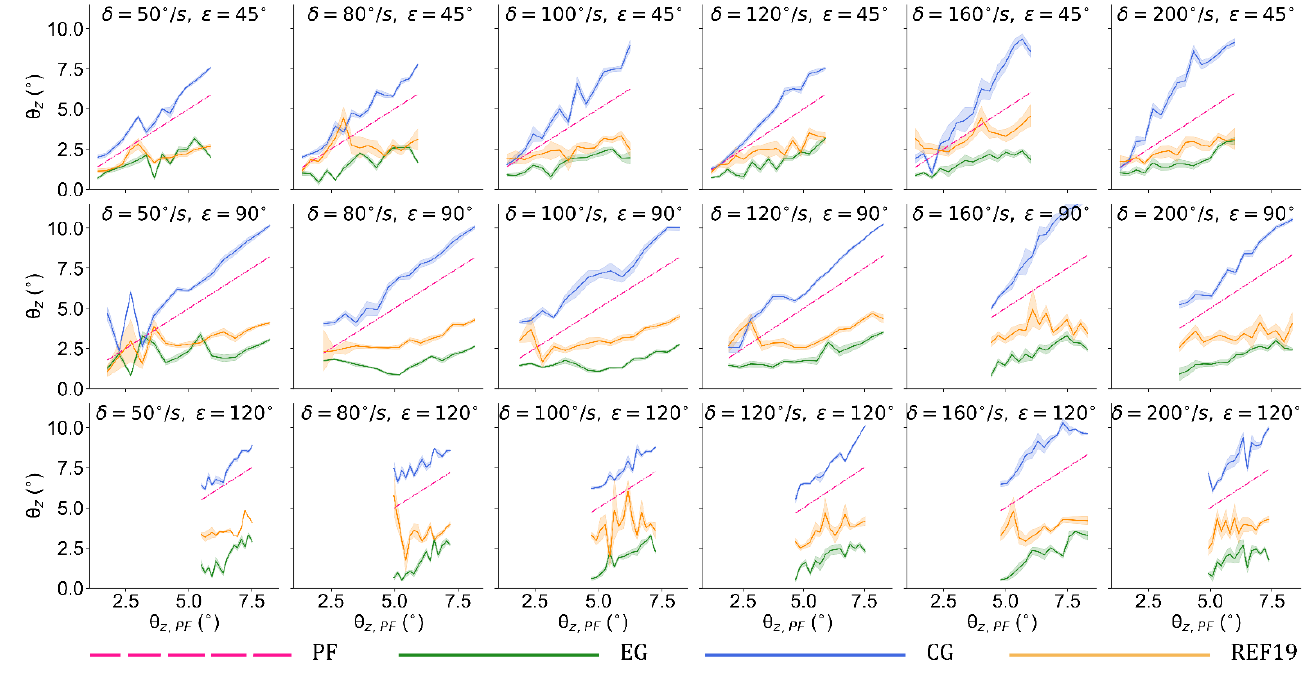
Figure 7. Balance performance under 18 vibration conditions.